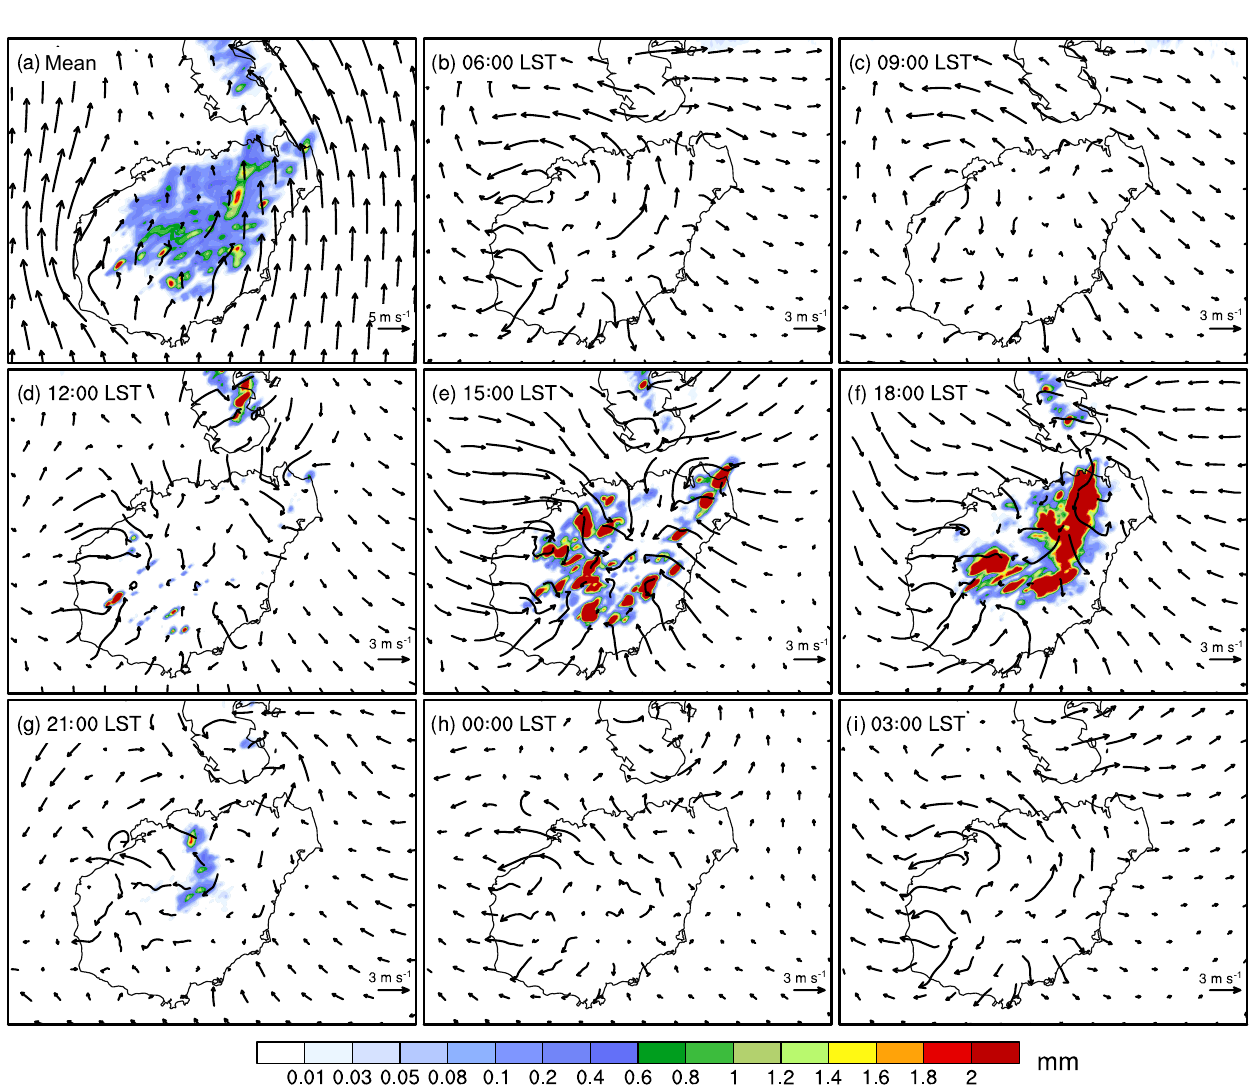
Figure 8. Hourly precipitation accumulation (shading) and average perturbation wind (vectors) on the second-lowest model level for hori- zontal wind in the REAL experiment every 3h. The averages over all hours are shown in (a) .